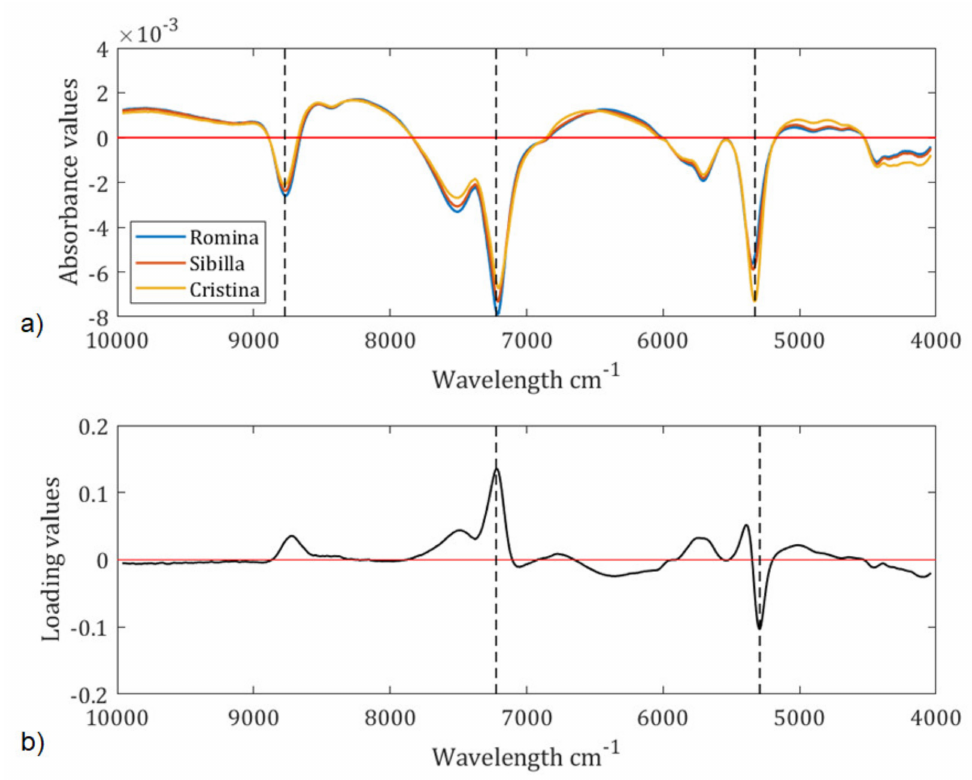
Figure 3. ( a ) Average spectra of Cristina, Sibilla and Romina cultivars pretreated using first derivative (Savitzky–Golay filter, 21 smoothing points, 2nd polynomial order); ( b ) Second loading. The dotted lines highlight the most important di ff erences among the three